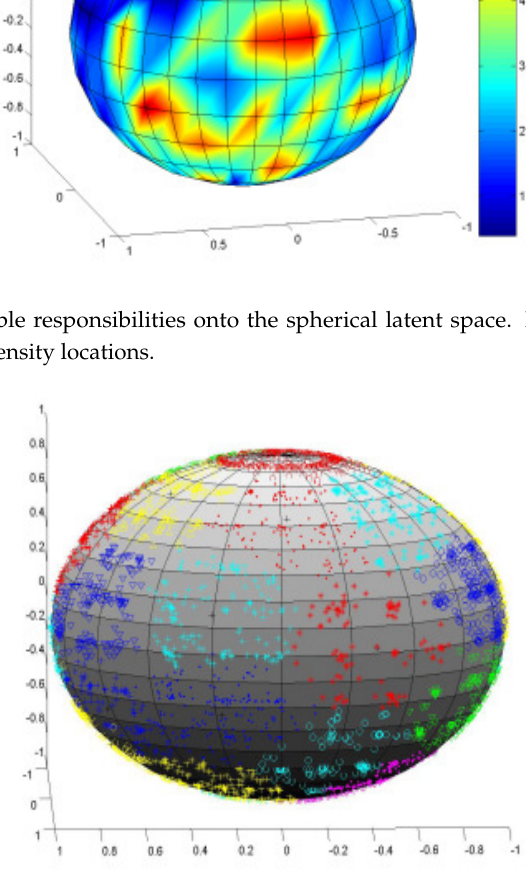
Figure 2. Visualization of resulting clusters from a hierarchical